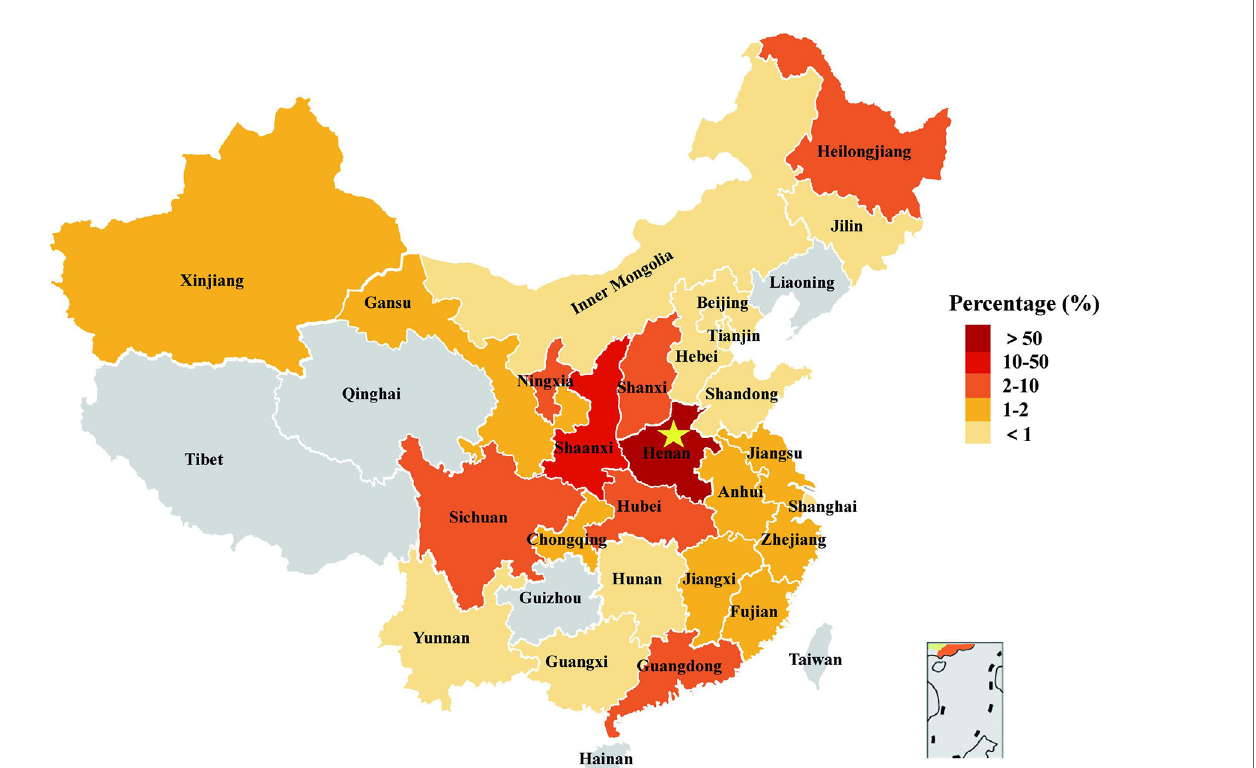
FIGURE 2 | Regional distribution ofspecimen source. Wecounted the geographicalorigin of 1948 patients from 26 provinces/autonomousregions/municipalities in